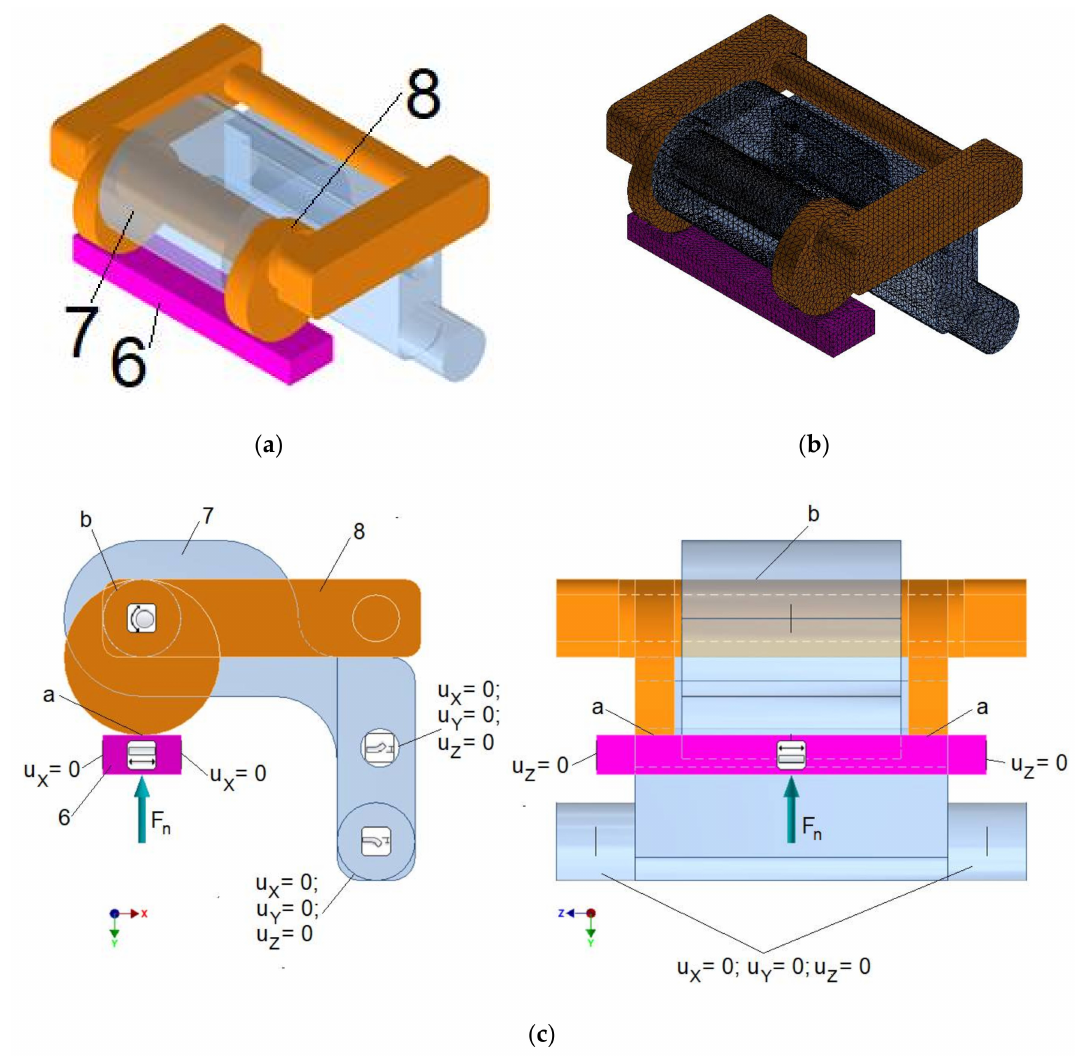
Figure 6. The model for determining contact pressure between eccentric and swivel arm. ( a ) Geometry of components; ( b ) Finite element grid; ( c ) Boundary